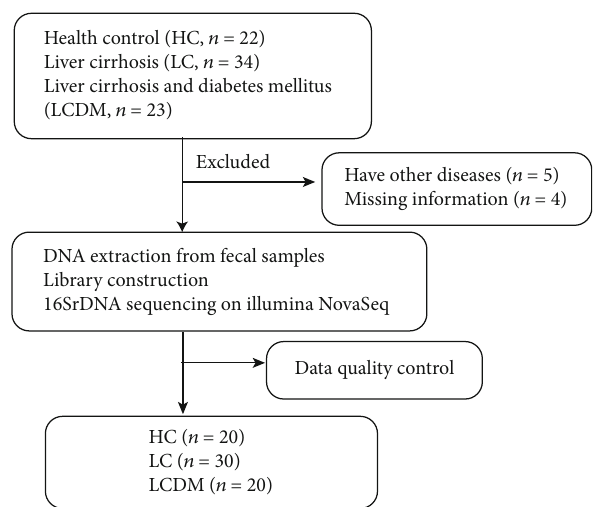
Figure 1: Research design and fl ow chart. A total of 79 stool samples were collected from Beijing Ditan Hospital, Capital Medical University. After strict inclusion and exclusion process, 70 samples were fi nally enrolled in, including 20 cases of healthy controls (HC), 30 cases of HBV-related liver cirrhosis (LC), and 20 cases of hepatitis B liver cirrhosis and diabetes mellitus (LCDM). The characteristics of intestinal microbiota were analyzed of the included